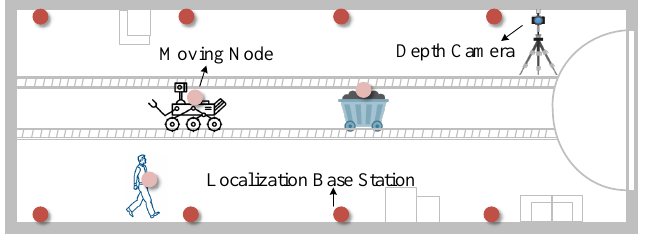
Figure 12. Underground tunnel